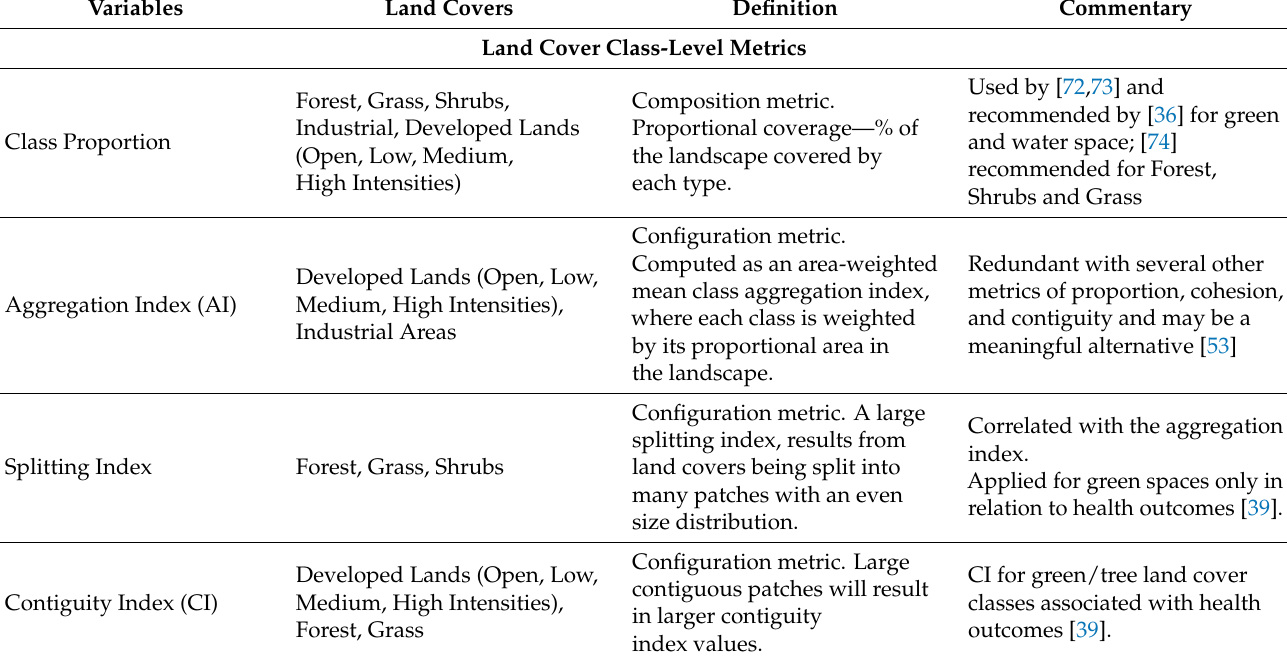
Table 2. Overview of the area-based and individual